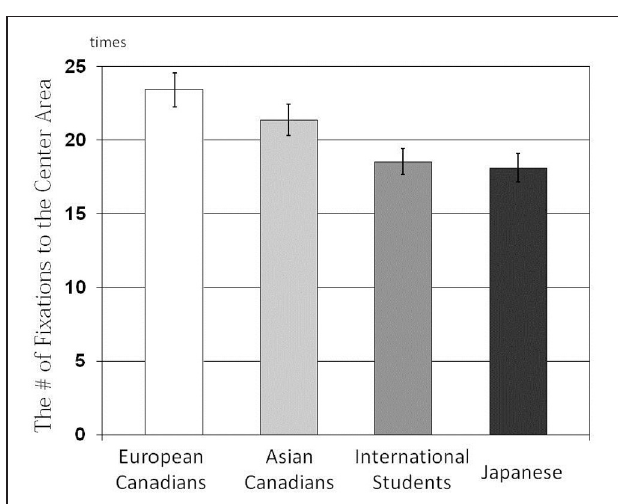
FIGURE 4 | Example of the division between the center area and the background area in an experimental image. The total number of fixations and fixation duration for each of the two areas were recorded separately.